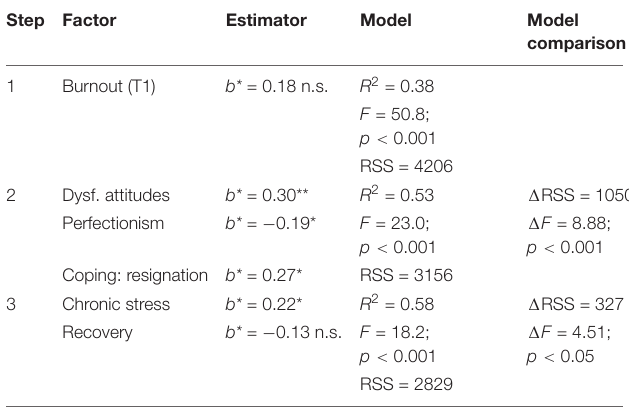
TABLE 2 | Hierarchical multiple linear regression results regarding